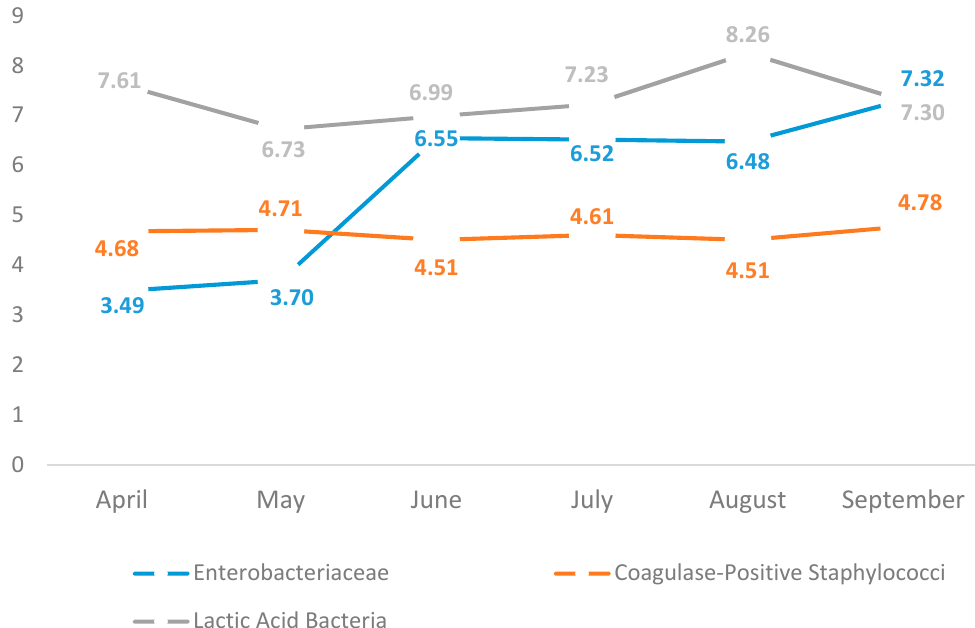
Figure 2. Means and their standard deviations (mean ± SD) of selected bacteria (log CFU/mL) in samples of raw sheep milk.